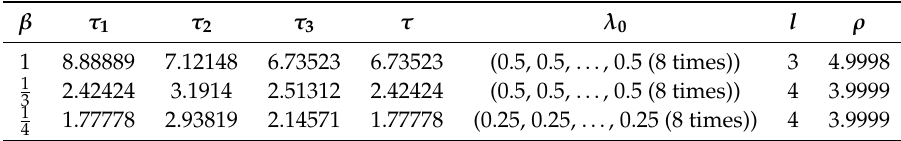
Table 2. Distinct convergence radii for Example